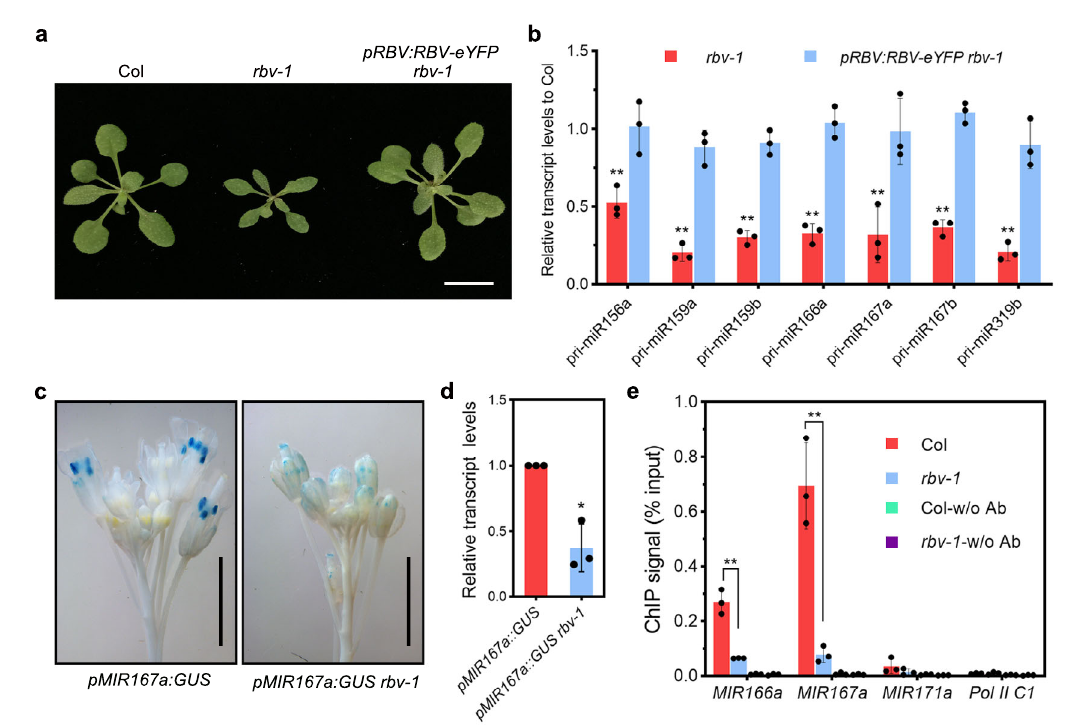
Fig. 3 RBV promotes the transcription of MIR genes. a Three-week-old plants of the indicated genotypes. Bar = 1 cm. b Levels of seven pri-miRNAs in 14- day-old seedlings of rbv-1 and the complementation line pRBV:RBV-eYFP rbv-1 as determined by RT-qPCR. UBQ5 was used as the internal control. Error bars represent standard deviation calculated from three independent replicates. (Student ’ s t test, ** P < 0.01). c Representative images of GUS staining of pMIR167a:GUS and pMIR167a:GUS rbv-1 in fl orescences. Bars = 2 mm. d Transcript levels of GUS from the two genotypes as determined by RT-qPCR. The expression values were relative to pMIR167a:GUS . Error bars represent standard deviation calculated from three independent replicates. (two-tailed Student ’ s t test, * P < 0.05). e RBV is required for the recruitment of Pol II to MIR166a and MIR167a promoters. The occupancy of Pol II at various regions was determined by ChIP with rbv-1 and Col using an antibody that recognizes the C-terminal repeat (YSPTSPS) of the largest subunit of Pol II. ChIP performed without the antibody served as a negative control. A genomic region between the genes AT2G17460 and AT2G17470 named Pol II C1 was also used as a negative control. Mean and standard deviation from three independent replicates are presented. (Student ’ s t test, ** P < 0.01). Source data are provided as a Source Data fi